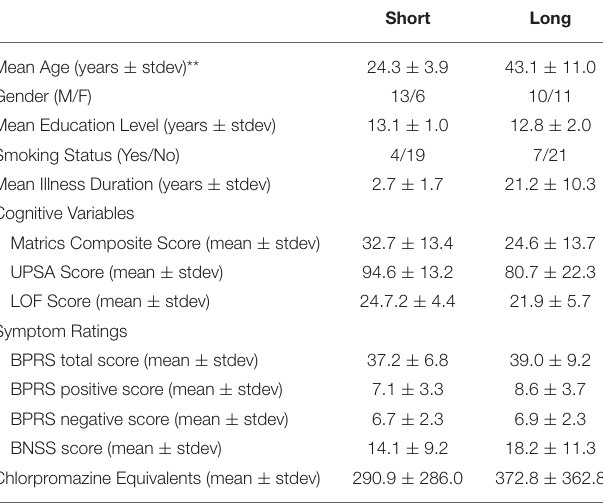
TABLE 2 | Participant demographics for short and long illness duration.